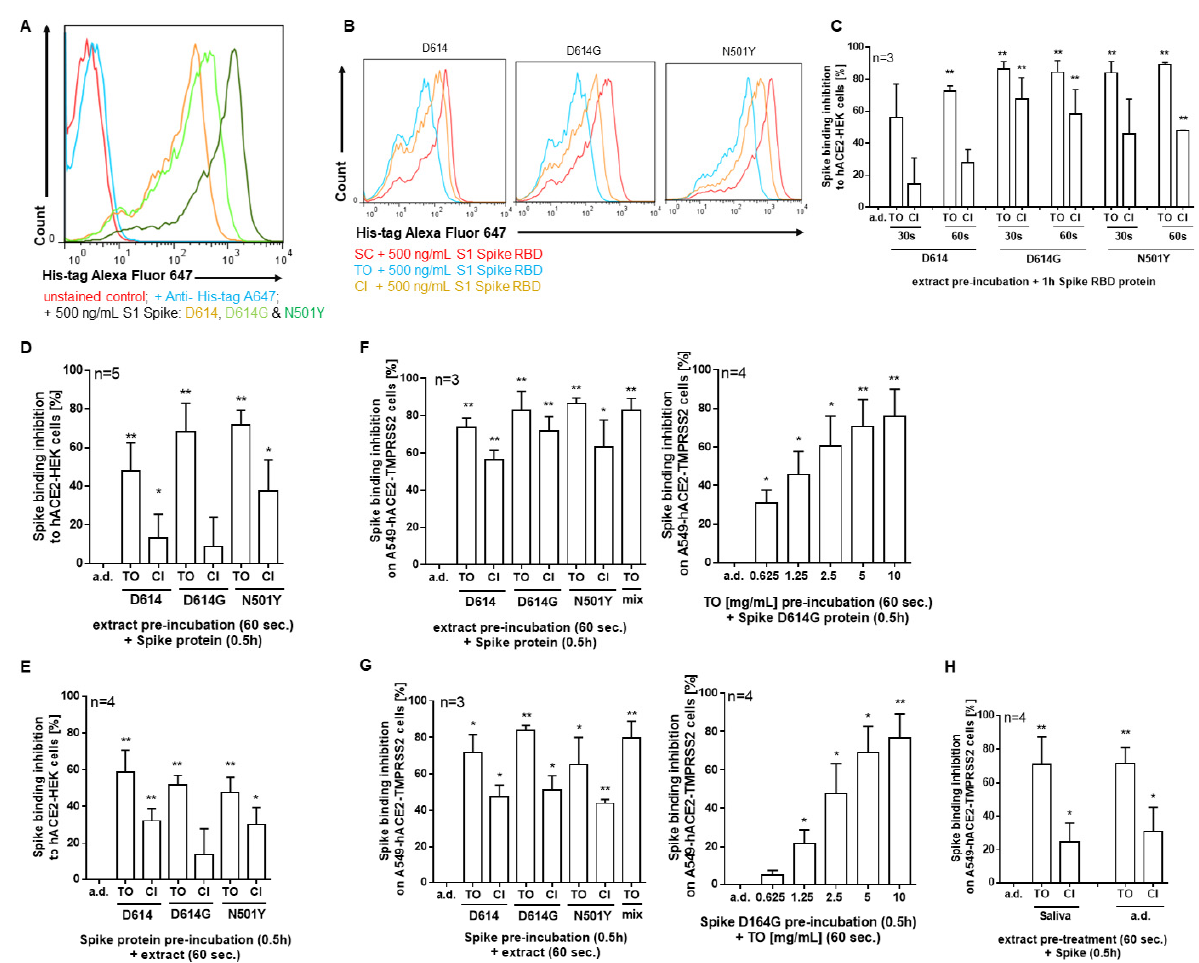
Figure 4. Binding inhibition of spike D614, and its mutants D614G, N501Y or mix (N501Y, K417N and E484K) to human HEK293-hACE2 and A549-hACE2-TMPRSS2 cells by extract pre- or post-incubation. Overlay of fluorescence intensity histogram for ( A ) unstained HEK cells, staining control (anti-His-tag Alexa Fluor 647), and cells incubated with His-tag- labelled spike D614, D614G or N501Y for 1 h at 4 ◦ C. ( B , C ) cells pre-incubated with solvent control (a.d.), 10 mg/mL T. officinale (TO) or 10 mg/mL C. intybus (CI) for 30–60 s, and then treated with His-tag-labelled S1 spike D614, D614G or N501Y protein for 1 h without a washing step in between at 4 ◦ C. ( D – G ) Effect of extract incubation on HEK or A549 cells either before or after incubation with His-tag-labelled spike D614, D614G, N501Y or mix (N501Y, K417N and E484K) protein at 37 ◦ C. ( H ) Plant extracts were incubated in saliva from four human donors for 0.5 h at 37 ◦ C. Afterwards, cells were pre-treated with 5 mg/mL extracts for 60 s at 37 ◦ C before incubation with His-tag-labelled spike D614 protein for 0.5 h at 37 ◦ C. Spike-binding inhibition to human cells was assessed using flow cytometric analysis of cells stained with anti-His-tag Alexa Fluor 647 conjugated monoclonal antibody. Bars are means + SD; * p < 0.05, ** p < 0.01. Significance of difference was calculated relative to the respective solvent control by one-way